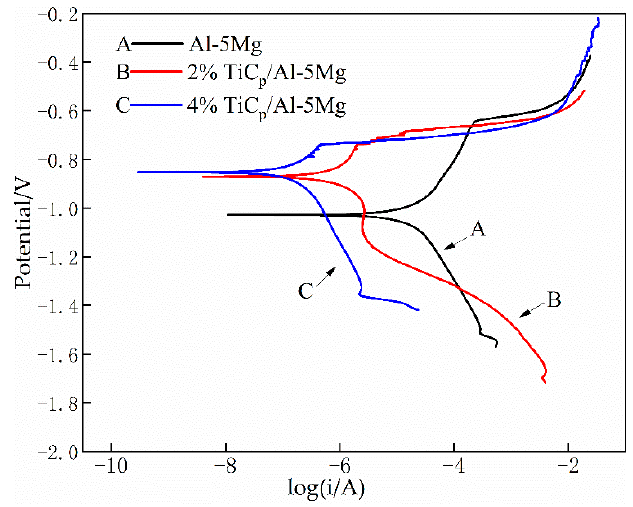
Figure 9. Polarization curves of the weld with and without TiC particles.